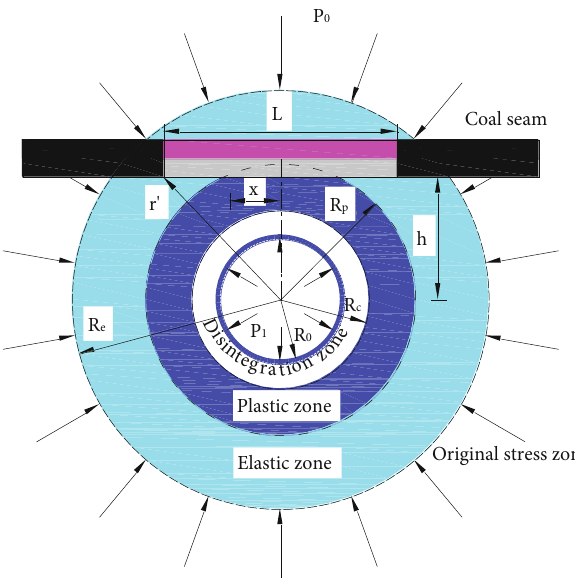
Figure 4: Pressure relief zoning model of fl oor roadway.